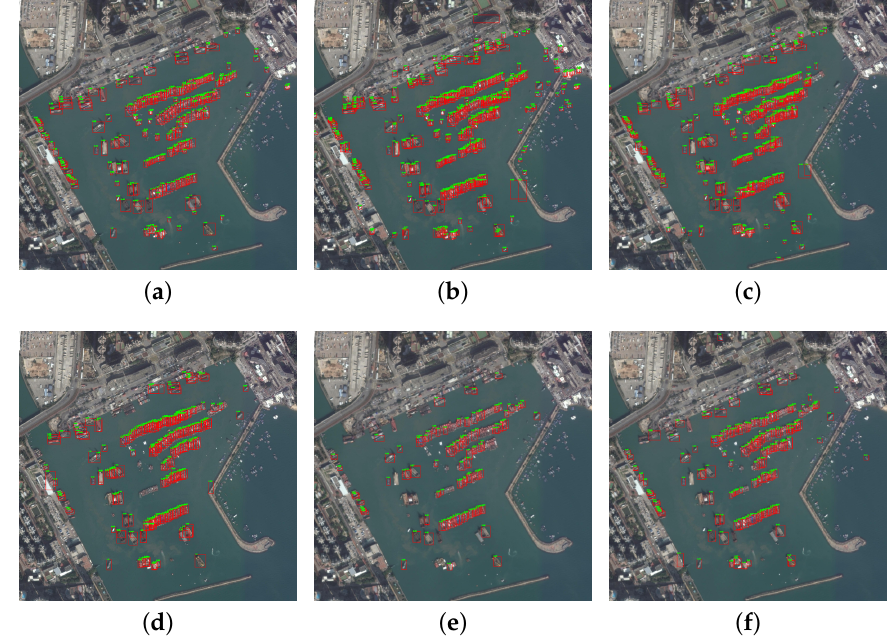
Figure 14. The specific example from six different methods. ( a ) The CF-SDN detection result. ( b ) The C-SDN detection result. ( c ) The Faster-RCNN detection result. ( d ) The SSD detection result. ( e ) The RCNN detection result. ( f ) The RCNN-based ship detection